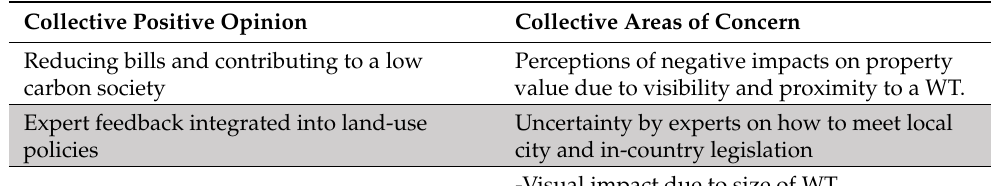
Table 1. Analysis of the Stage 1: Experts Open-Ended Survey Based on